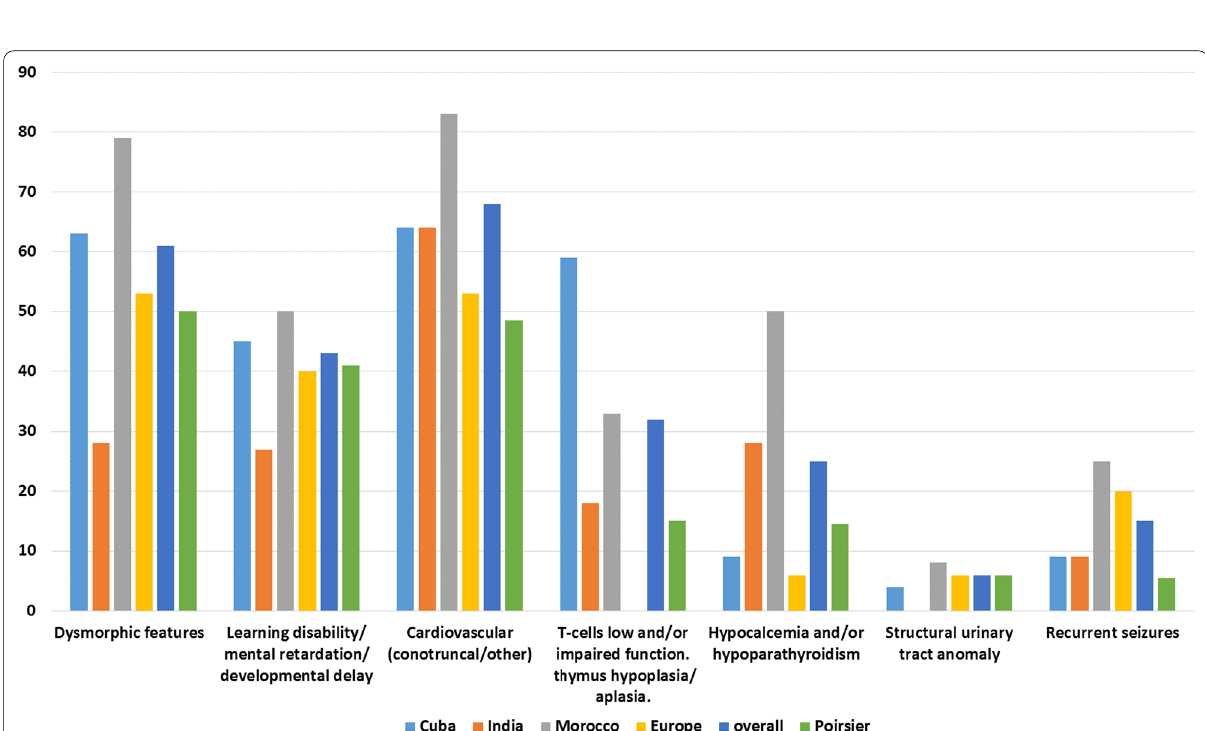
Fig. 1 Seven main clinical features observed in the here reported patients from Cuba, India, Morocco, Europe and overall are compared to those reported in the review of Poirsier et al.